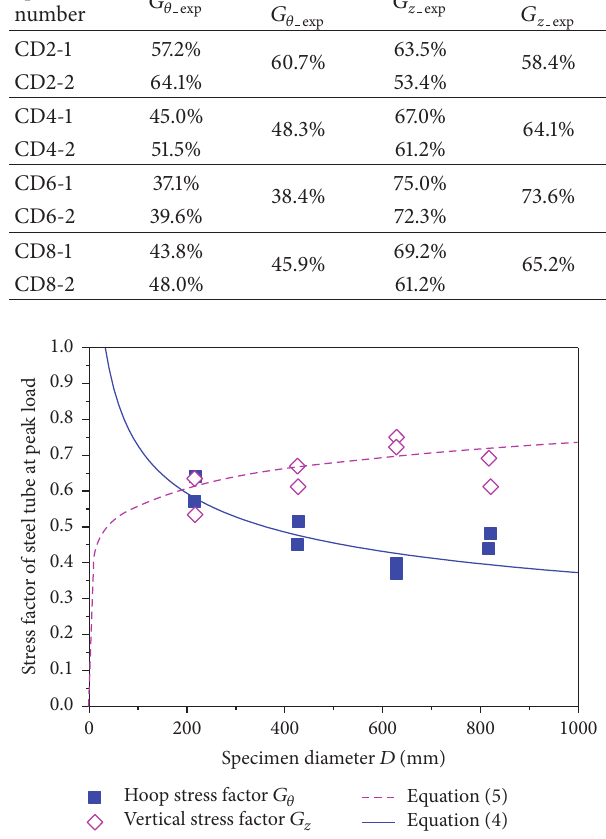
Figure 9: Relationship between stress factors of steel tube and specimen size at moment of peak load.